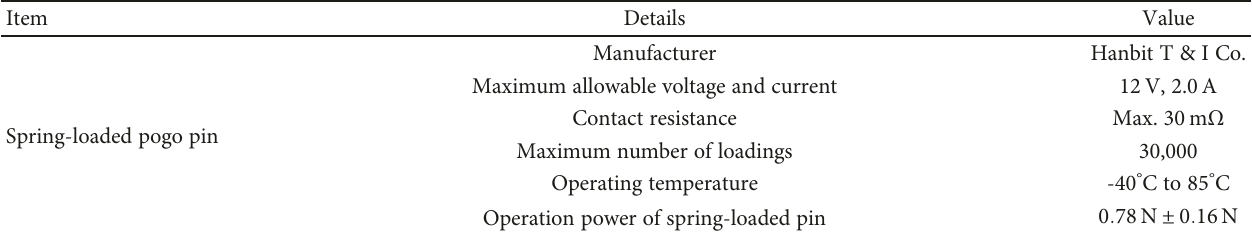
Table 1: Speci fi cations of spring-loaded pogo